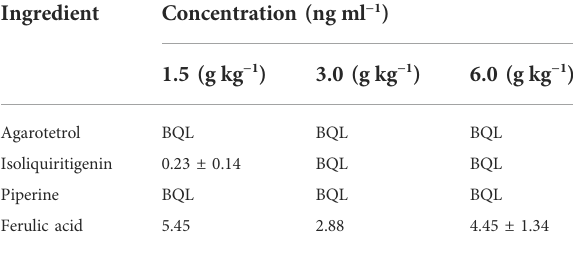
TABLE13Testresultsoffourcomponentsafter15 daysofwithdrawal.